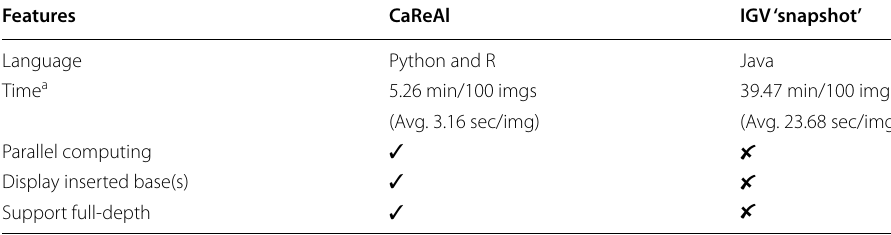
a Randomly selected 100 targets in whole-genome sequencing with 40